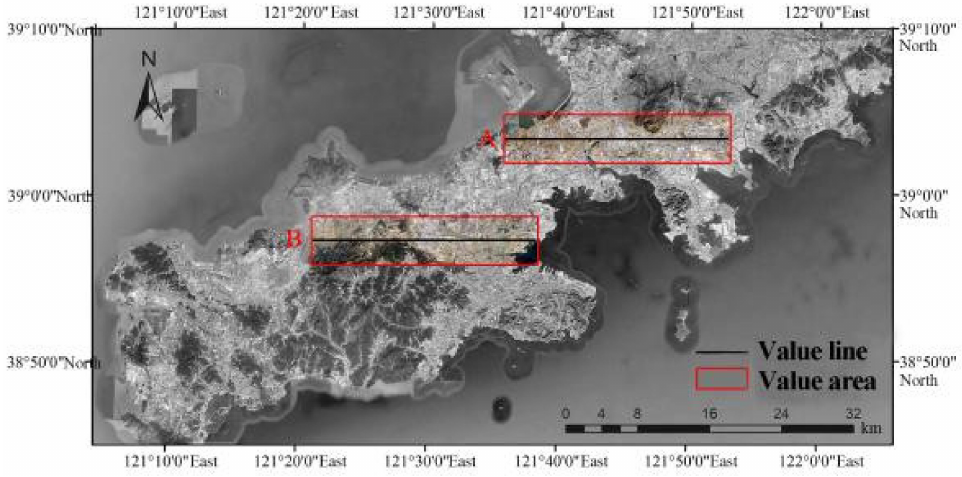
Figure 17. Location diagram of value